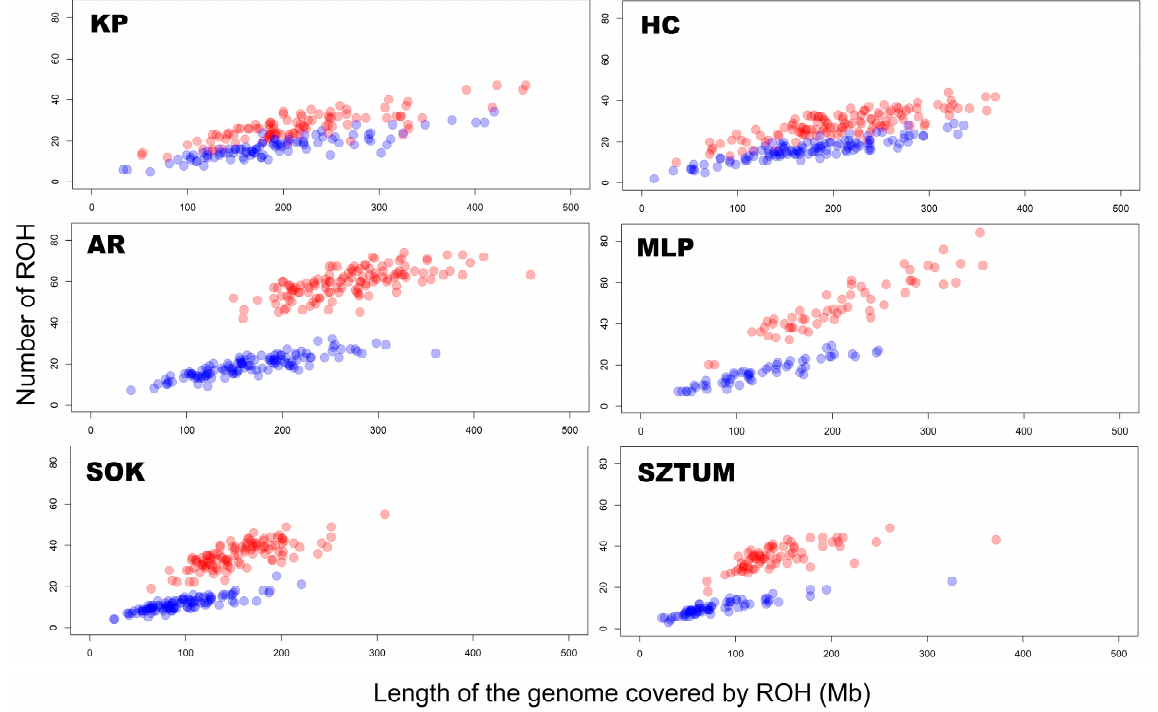
Figure 1. The number and length of runs of homozygosity per animal for each horse breed and type. The blue color represents all ROH, while the red color represents ROH above 4 Mb.